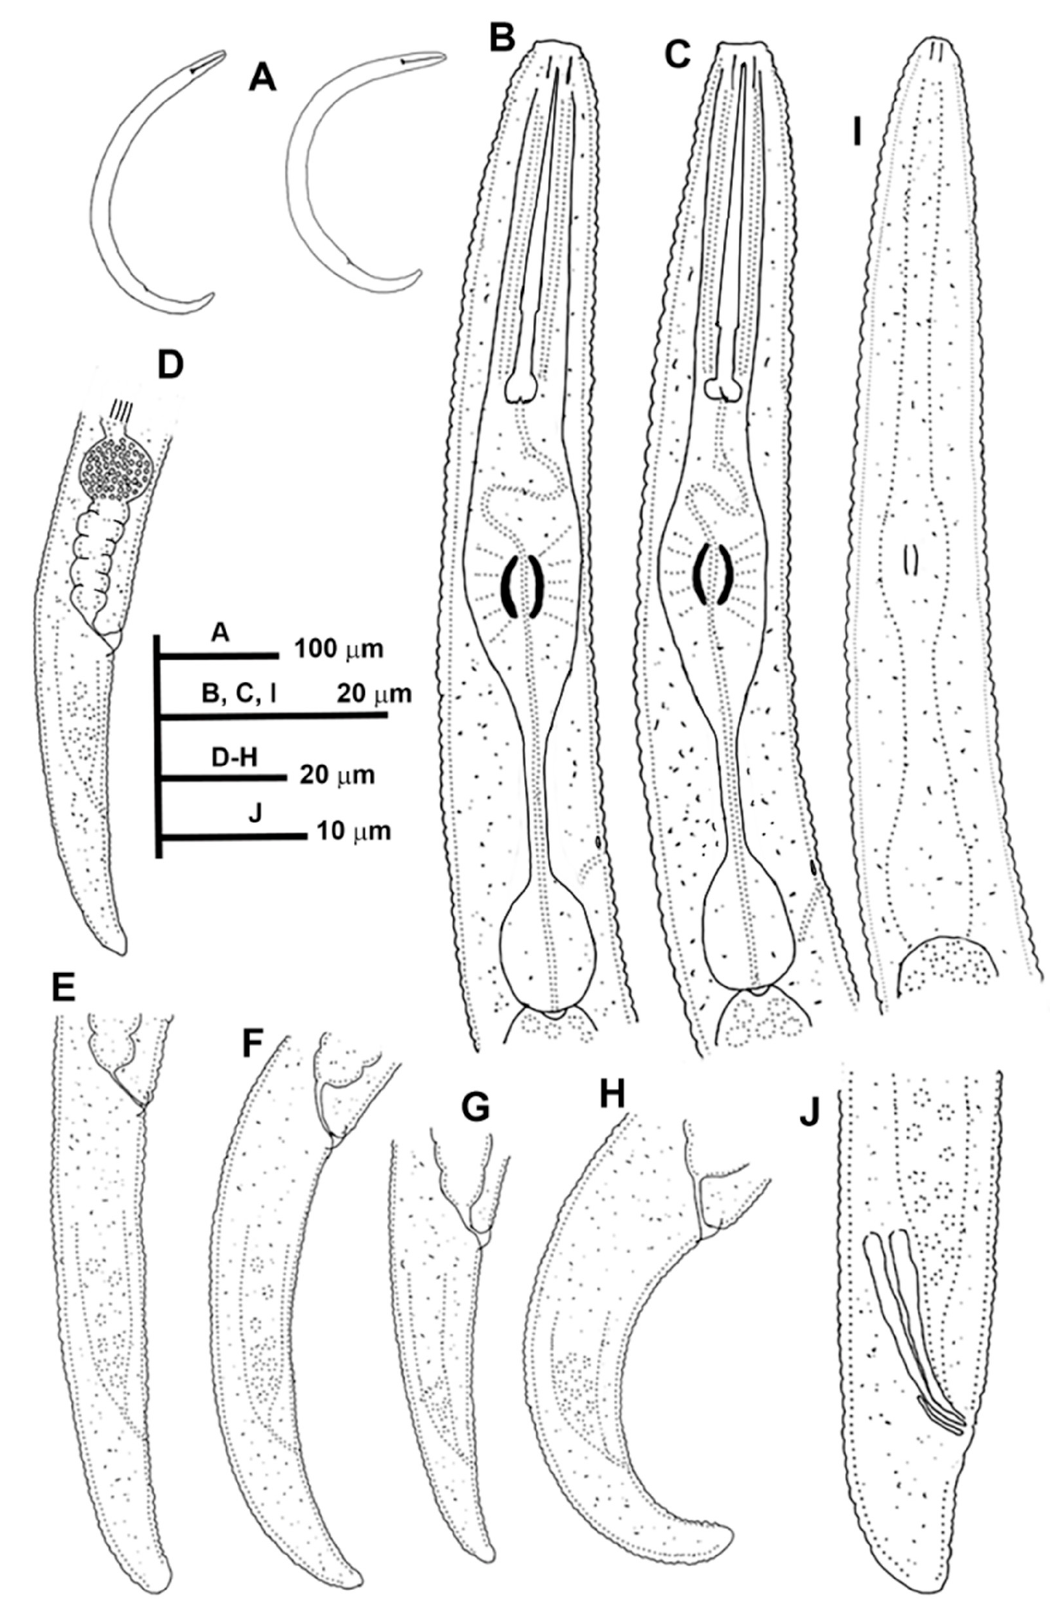
Figure 6. Line drawings of Paratylenchus pedrami sp. nov. ( A ): Entire females; ( B , C ): Female pharyngeal region; ( D – H ): Female posterior region; ( I ): Male pharyngeal region showing absence of stylet; ( J ): Male posterior region.